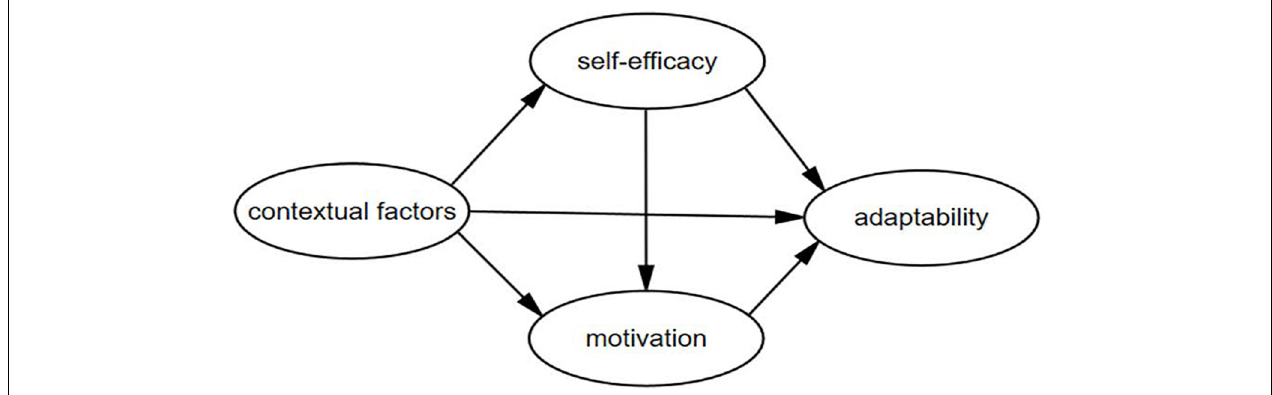
FIGURE 1 | The research model for adaptability in blended learning